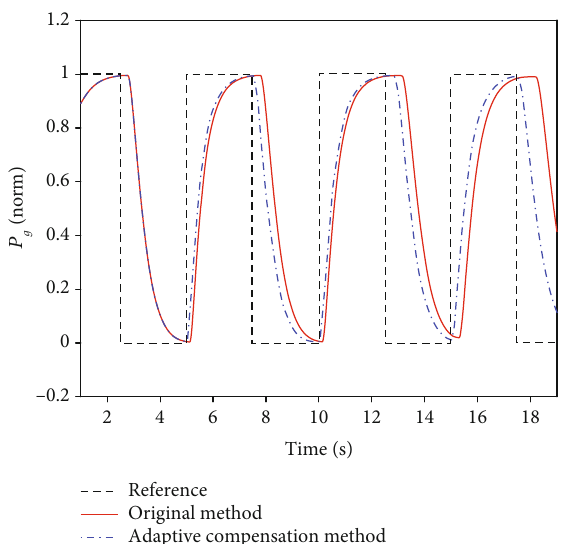
Figure 17: Simulation results of backlash compensation in an adaptive case (part II blowup).